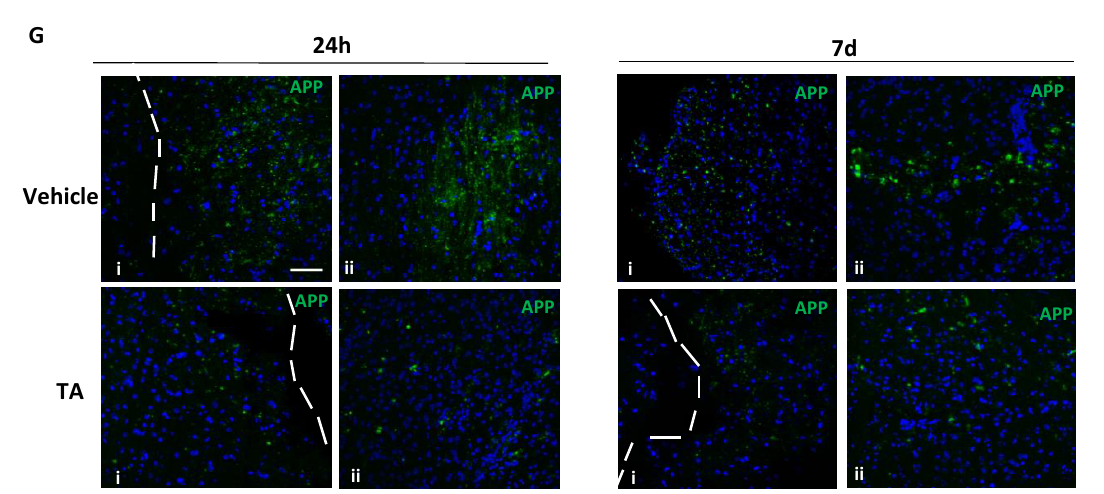
Figure 6. TLR4 antagonism decreased serum and brain SAA1 levels 1 day after TBI. ( A ) TAK242 (3 mg/kg) reduced serum SAA1 protein levels. Mice were treated 1 h after CHI (sham, n = 8; vehicle, n = 10; TAK, n = 8). * p < 0.05 and *** p < 0.001, 1-way ANOVA with Tukey’s multiple comparisons test. ( B ) Treatment reduced cerebral accumulation of SAA1 at one day post-injury (sham, n = 4; vehicle, n = 11; TAK, n = 9). * p < 0.05, 1-way ANOVA with Tukey’s multiple comparisons test. ( C ) Brain lysates of mice treated with or without TAK242 were immunoblotted with SAA1 antibody and protein expression was quantified (sham, n = 4; vehicle ipsi and contra, n = 4; TAK242 ipsi and contra, n = 4). * p < 0.05, ** p < 0.01, 1-way ANOVA with Tukey’s multiple comparisons test. ( D ) SAA1 immunostainings and ( E ) quantification of SAA1 positive area of (i) and (ii) brain regions of mice subjected to TBI at the indicated time points, treated or not with TAK242 (vehicle ipsi and contra, n = 3; TAK242 ipsi and contra, n = 3). ** p < 0.01, 2-way ANOVA with Sidak’s multiple comparisons test. ( F ) Quantification of APP particles of (i) and (ii) regions and ( G ) APP immunostainings of brains of mice subjected to TBI at the indicated time points, treated or not with TAK242 (vehicle ipsi and contra, 24 h and 7 d, n = 4; TAK242 ipsi and contra, 24 h and 7 d, n = 4). *** p < 0.01, # p < 0.05, 2-way ANOVA with Sidak’s multiple comparisons test. Photos show the damaged hemisphere in an area immediately surrounding the injury site ((i) the nearest 50 µ m) and in a deeper area ((ii) between 50 and 100 µ m). Images are representative of each group. Scale bars: 5 µ m. White arrows indicate the limit of the cortical damaged area. Data of all experiments are represented as mean ± SD. Ipsi, ipsilateral hemisphere; contra, contralateral